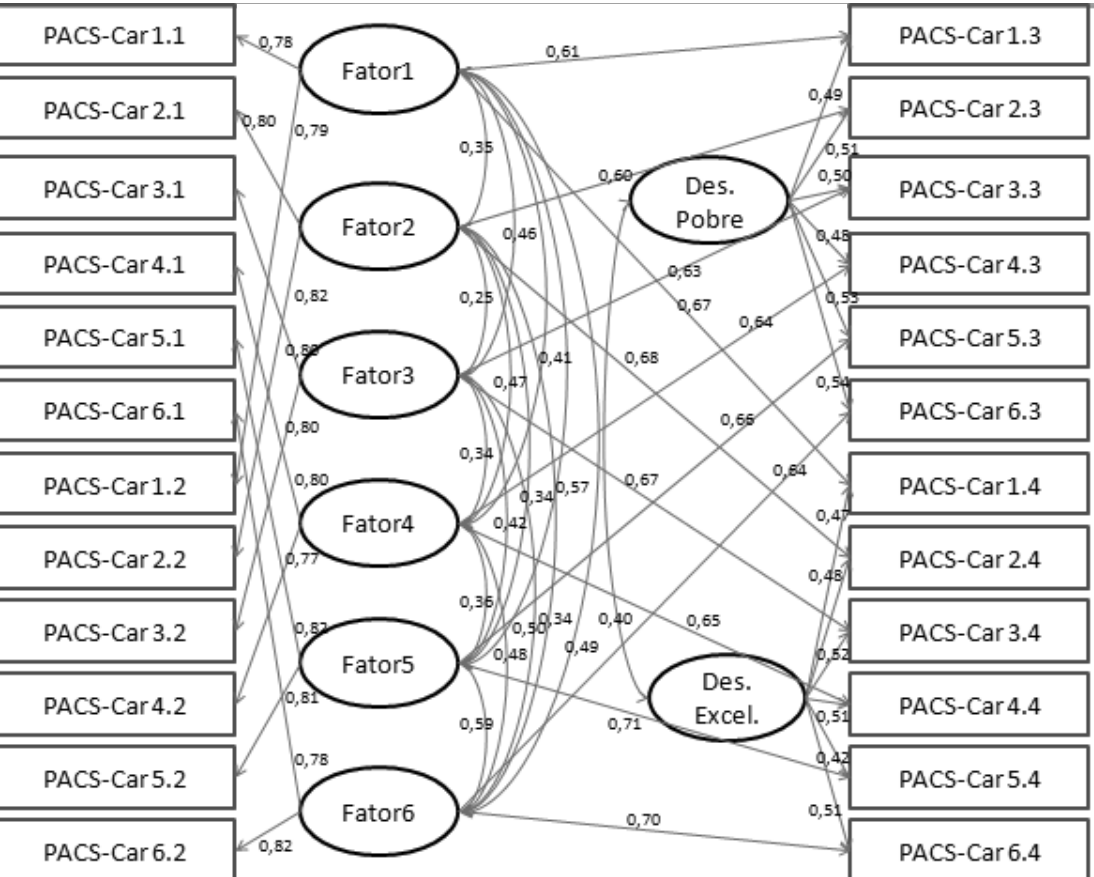
Figura 1 . Modelo de desempenho social na carreira com correlações entre todos os fatores e sem outliers .